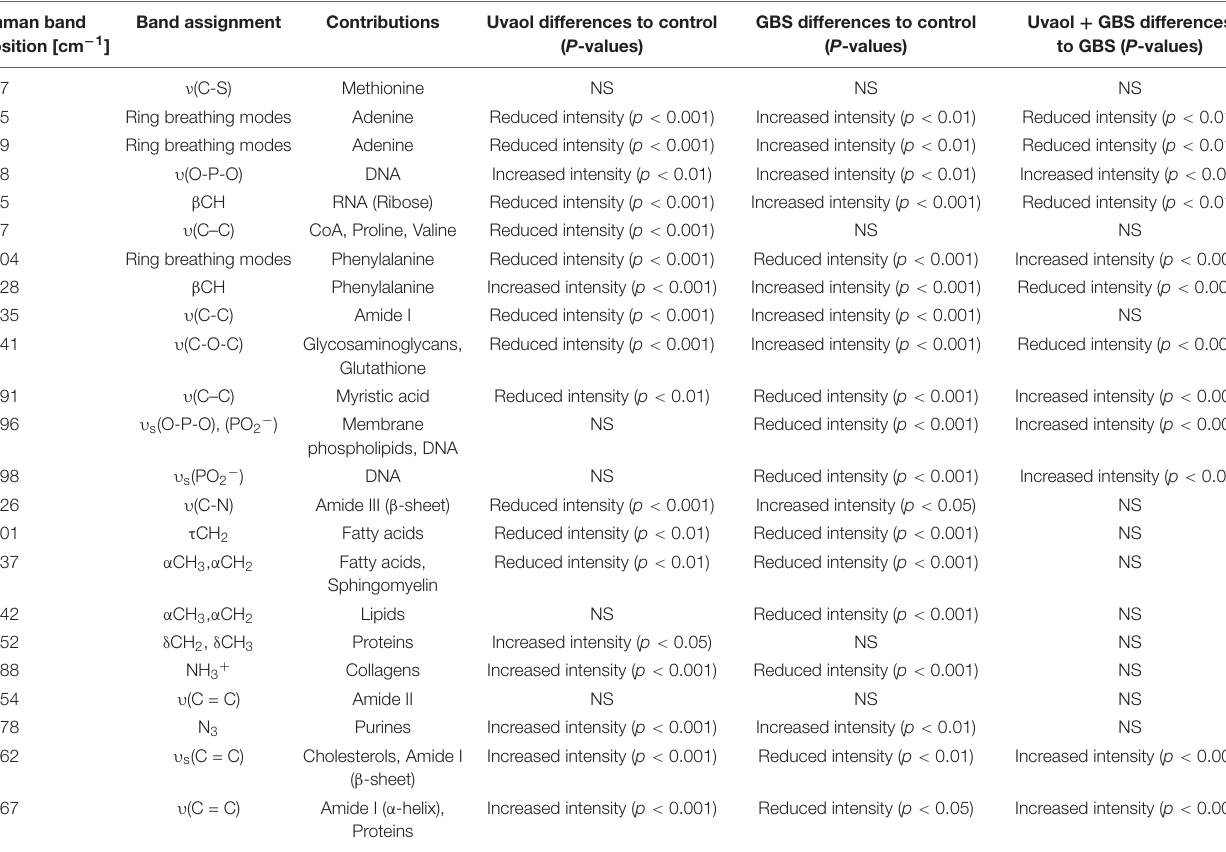
TABLE 1 | Raman bands position and their respective assignments and contributions. Raman band position [cm − 1